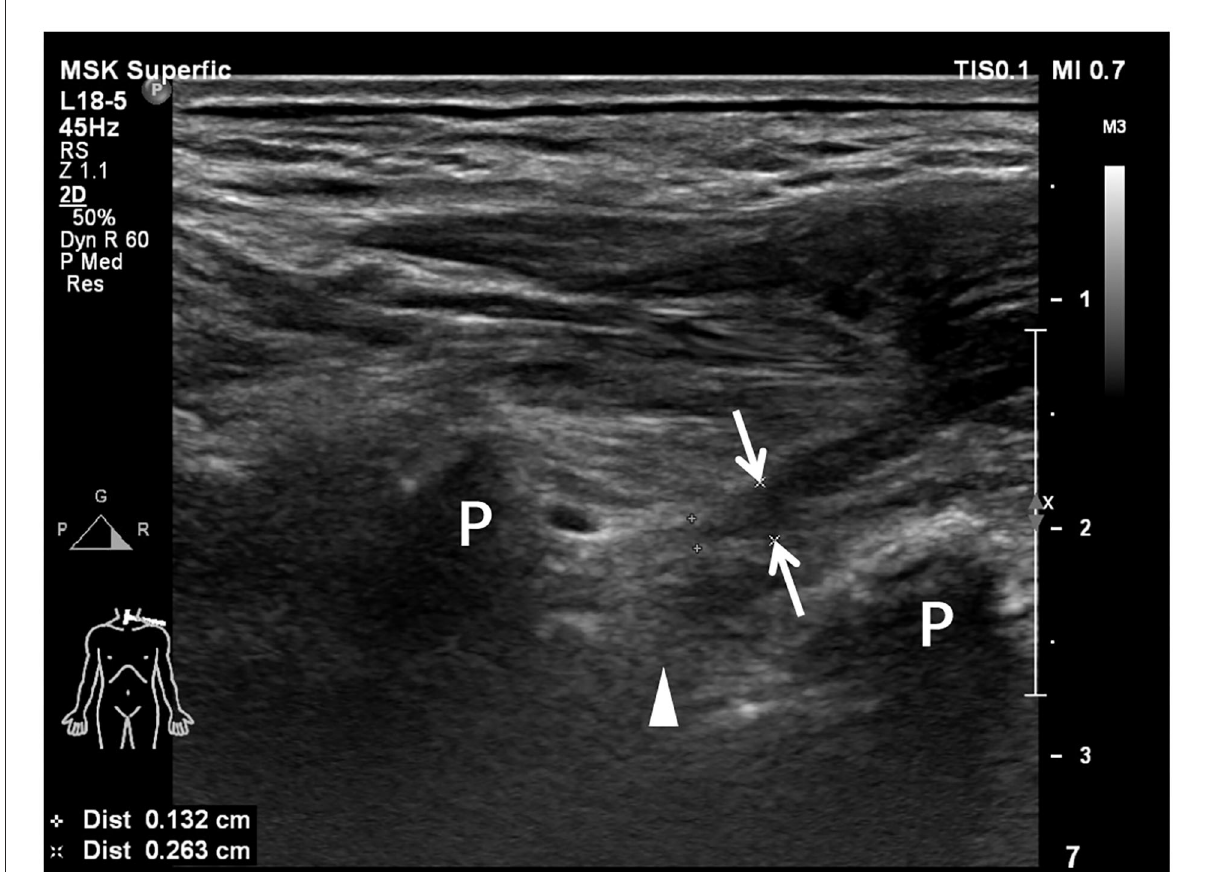
FIGURE1 Longitudinal sonogram shows a hypoechoic irregular neural stump (arrows) with a blind-ending of the hypoechoic brachial plexus root. An empty neural foramen (arrowhead) is visualized, indicating preganglionic avulsion of the nerve root. Transverse processes (P) of cervical vertebrae are shown as hyperechoic bone prominences with posterior acoustic